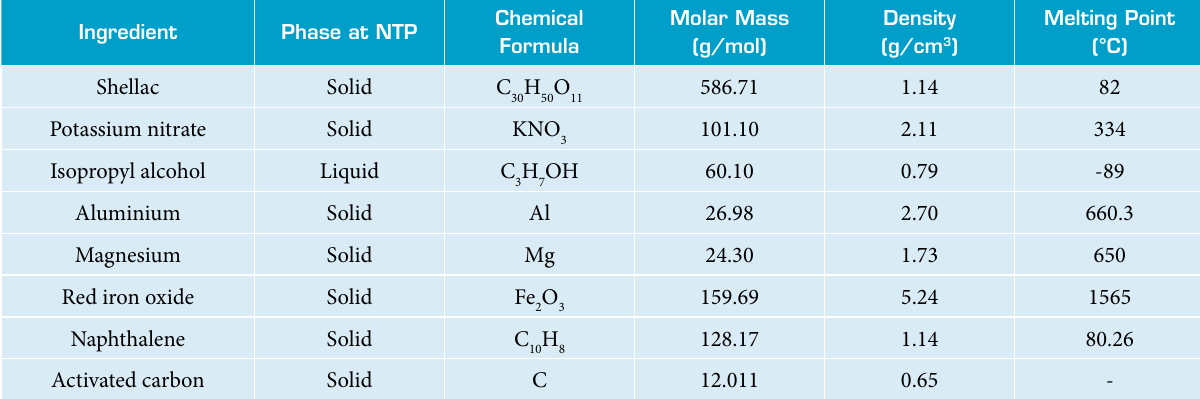
Table 1. Chemical and physical properties of the